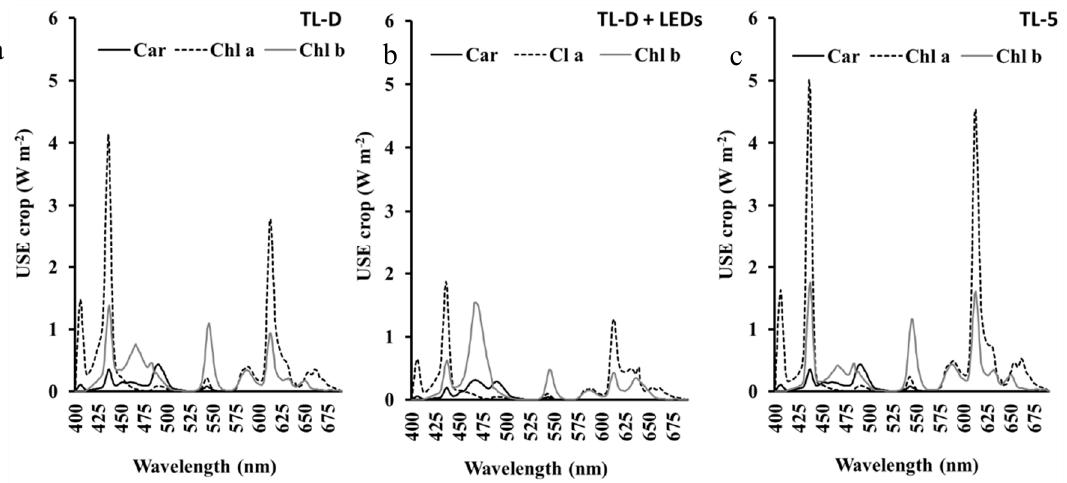
Figure 6. Use of spectral energy by each pigment of the crop (USEcrop) (chlorophyll a and b and carotenoids) in light treatments: ( a ) TL-D, ( b ) TL-D + LEDs and ( c ) TL-5. Table 4. Use of spectral energy by each pigment (USEpigment) (chlorophyll a and b and carotenoids) (expressed in W m − 2 ) in each light treatment. Values with the same letters are not significantly different at p < 0.05 (ANOVA and LSD test). ns: not significant. Data are the means ± standard deviation of five plants per treatment.